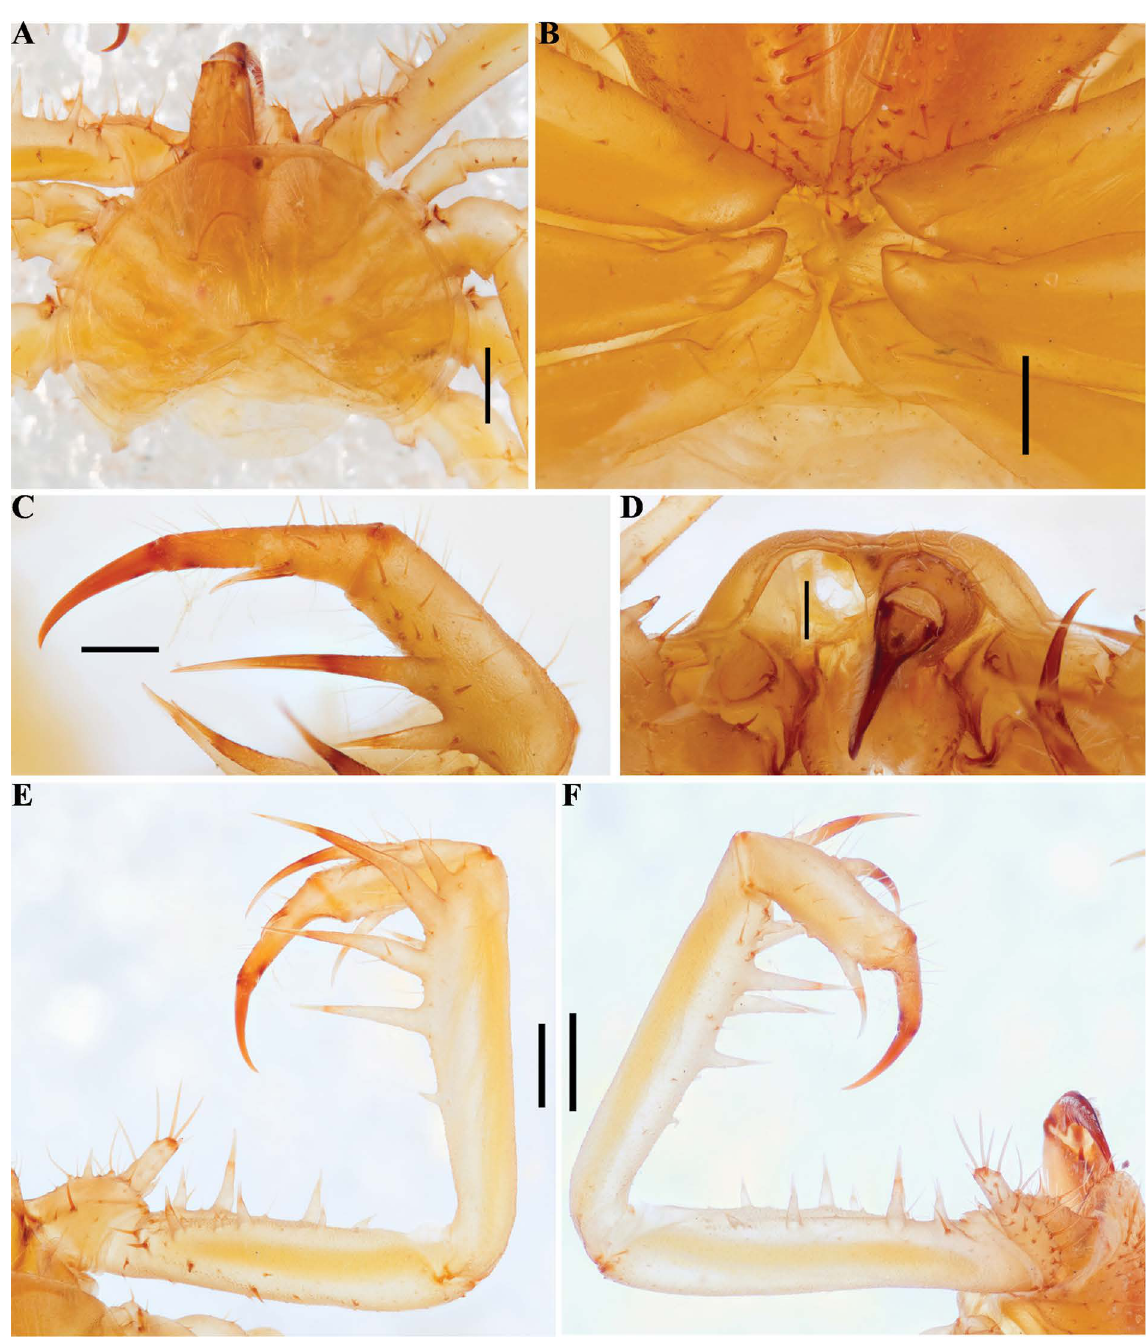
Fig. 82. Charinus susuwa sp. nov. (BMNH), general morphology, ♀. A . Carapace, dorsal view. B . Sternum, ventral view. C . Pedipalp tarsus, frontal view. D . Frontal process. E . Pedipalp, dorsal view. F . Pedipalp, ventral view. Scale bars: A, E–F = 1 mm; B–D = 0.5